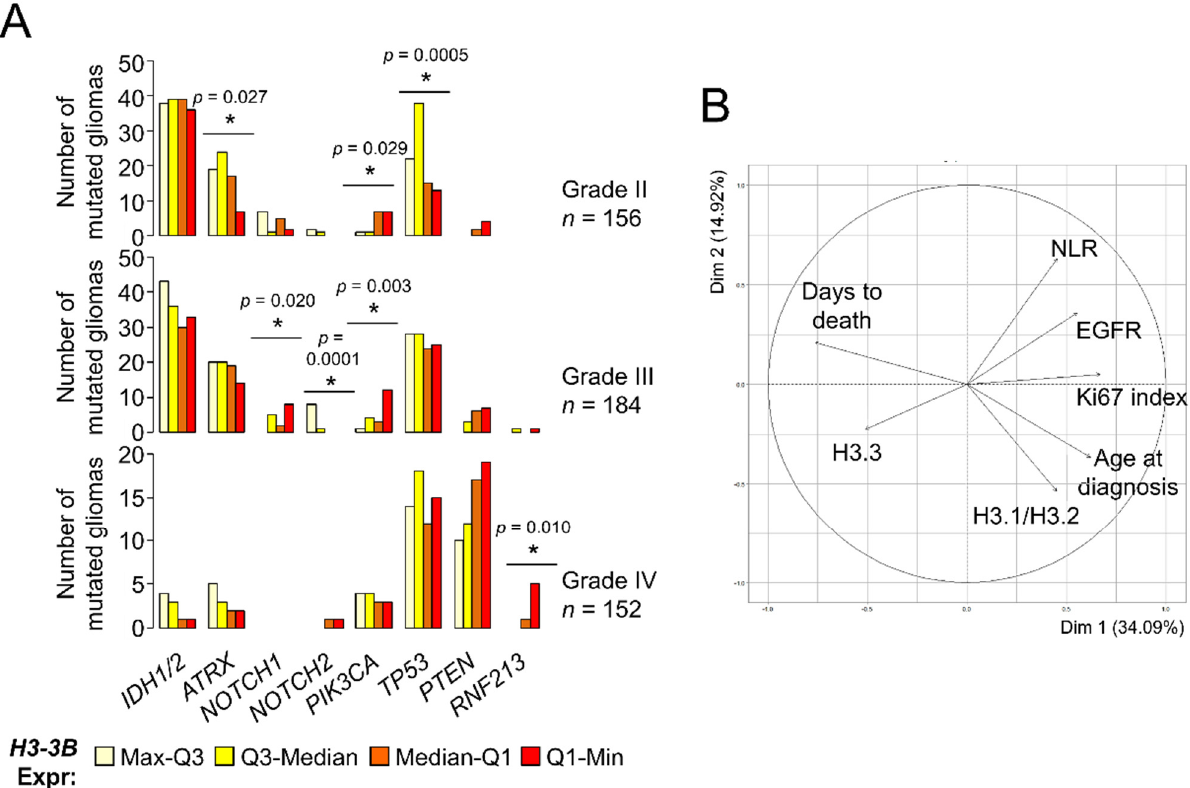
Figure 3. Levels of the histone H3 variants are associated with clinical parameters of gliomas. ( A ) Number of mutated gliomas based upon TCGA database information. Gliomas were classified in quartiles of H3-3B mRNA expression. The number of mutated gliomas across the quartile groups was compared to a random distribution. Note: * p < 0.05, χ 2 d.f. = 3. ( B ) Clustering of parameters (variables) in two dimensions according to PCA. The projection of the arrows indicates the dominance (direction) and degree of correlation (length) of the represented dimensions (principal components). Circle, maximum correlation.